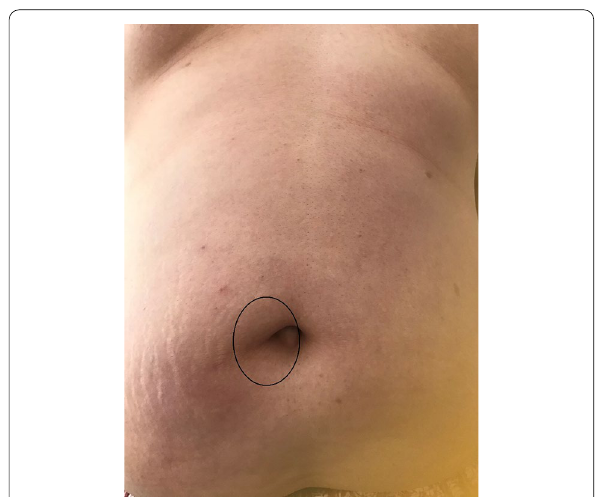
Fig. 1 Abdominal photograph of frontal view. A hernia orifice measuring approximately 4 cm is present in the umbilical region